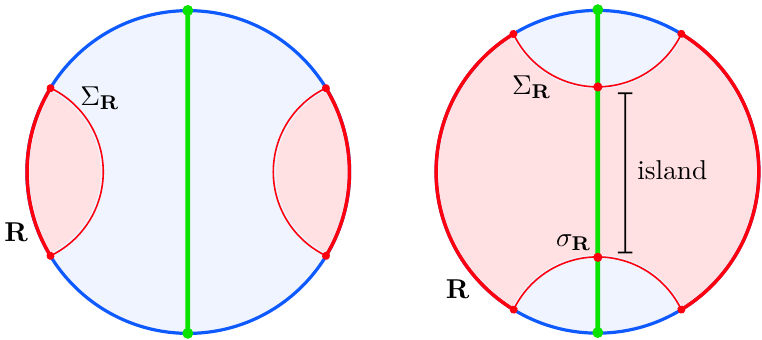
Figure 2. The choice of RT surfaces on a constant time slice in the presence of the brane (coloured green), showing the different ingredients involved in eq.